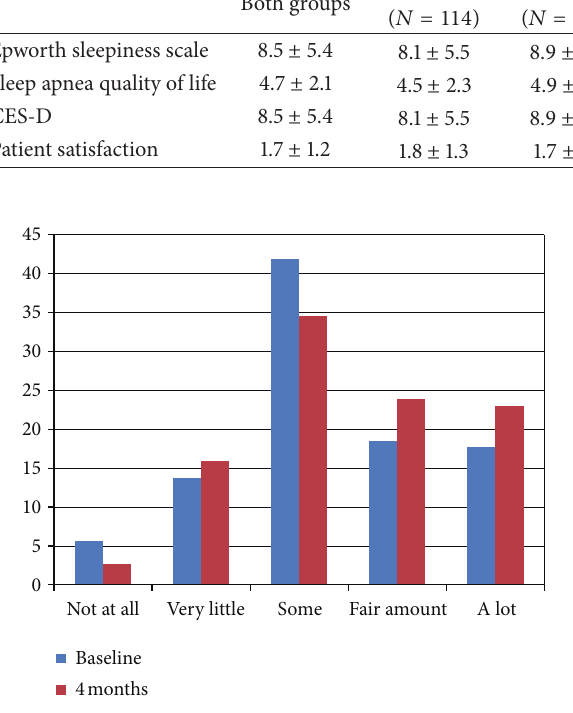
Figure 3: Frequency of response of how often the internet is used to get information on health, at both baseline and at four months (intervention group, only).